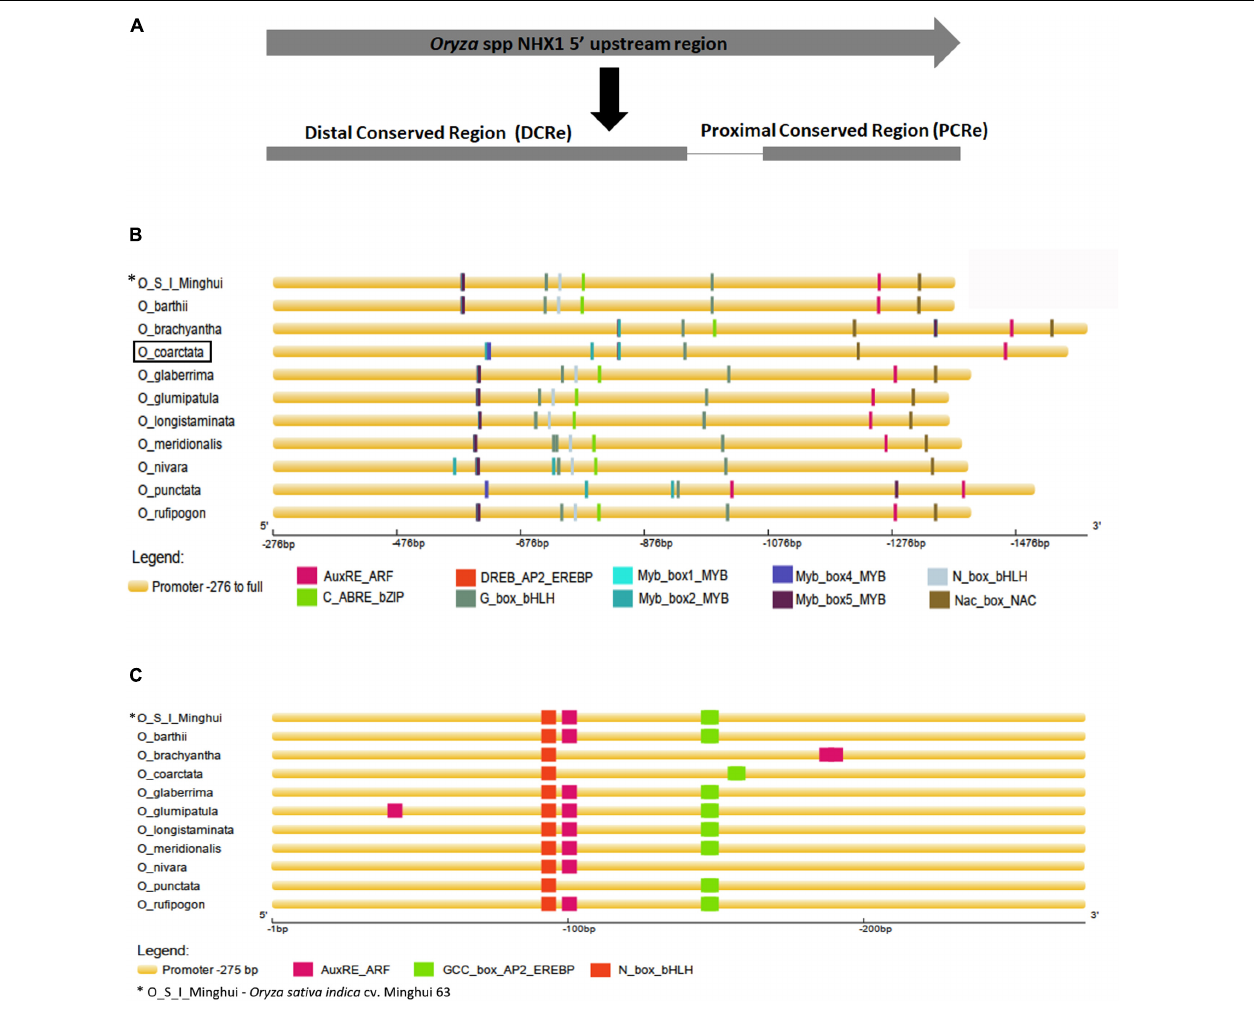
FIGURE 2 | Analysis of 5 (cid:48) upstream sequences from Oryza species. (A) Alignment of NHX1 5 (cid:48) upstream sequences from Oryza species shows two conserved stretches (i) Region 1, starting -276 bp upstream of the NHX1 5 (cid:48) UTR to the end of examined sequence ( O. coarctata NHX1 promoter sequence used as reference for numbering) and (ii) Region 2 encompassing bases -1 to -275 bp, upstream of the NHX1 5 (cid:48) UTR. (B,C) Prediction of transcription factor binding cis -elements using STIF DB2 (Naika et al., 2013) in the 5 (cid:48) upstream sequences of NHX1 ( Oryza species), Region 1 and Region 2 respectively, aligned